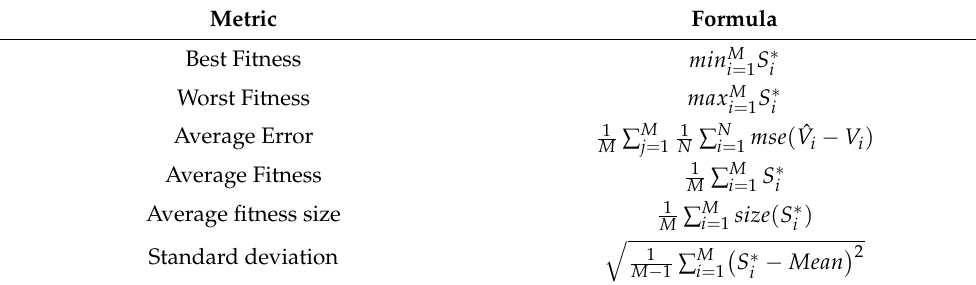
Table 3. Feature selection results evaluation criteria.